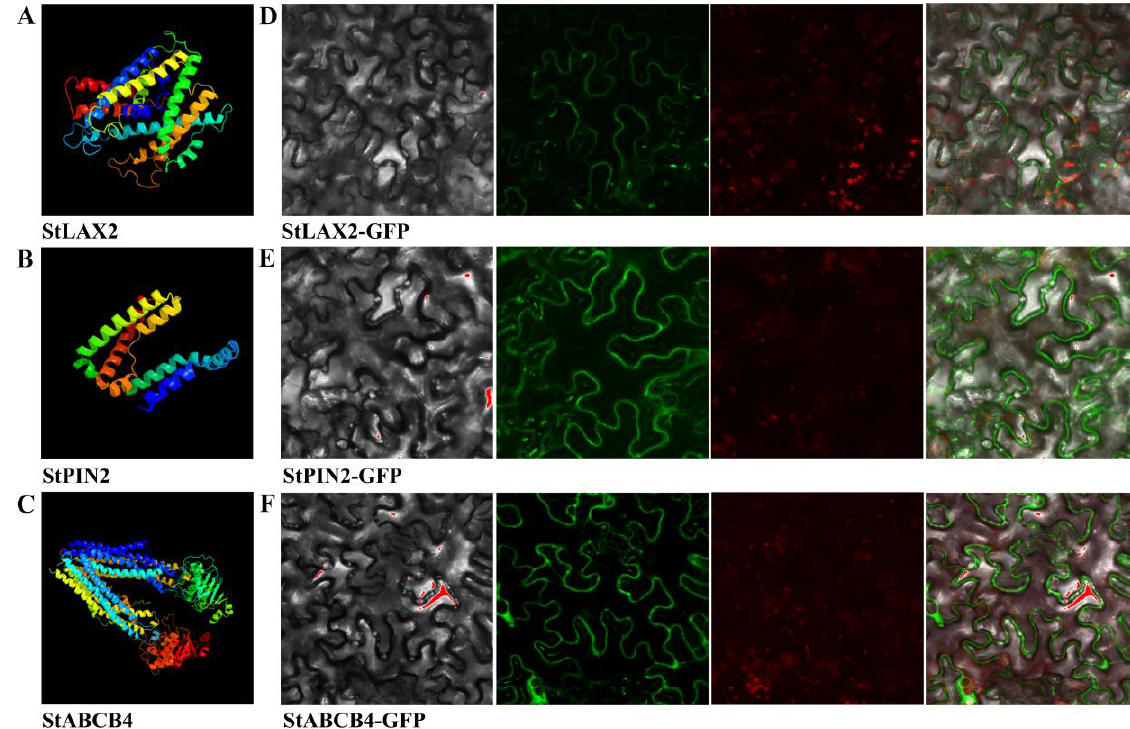
Figure 5. 3D structure prediction and subcellular localization of S. tuberosum auxin transporter proteins. 3D structure of consensus sequences of three typical ( A ) StLAX2, ( B ) StPIN2, and ( C ) StABCB4 were used for this analysis. Auxin transporter protein − GFP fusion proteins ( D ) StLAX2 − GFP, ( E ) StPIN2 − GFP, and ( F ) StABCB4 − GFP were transiently expressed in tobacco epidermis cells. Left to right: bright − field, green fluorescence of protein − GFP, chloroplast autofluorescence, and merged microscope images.